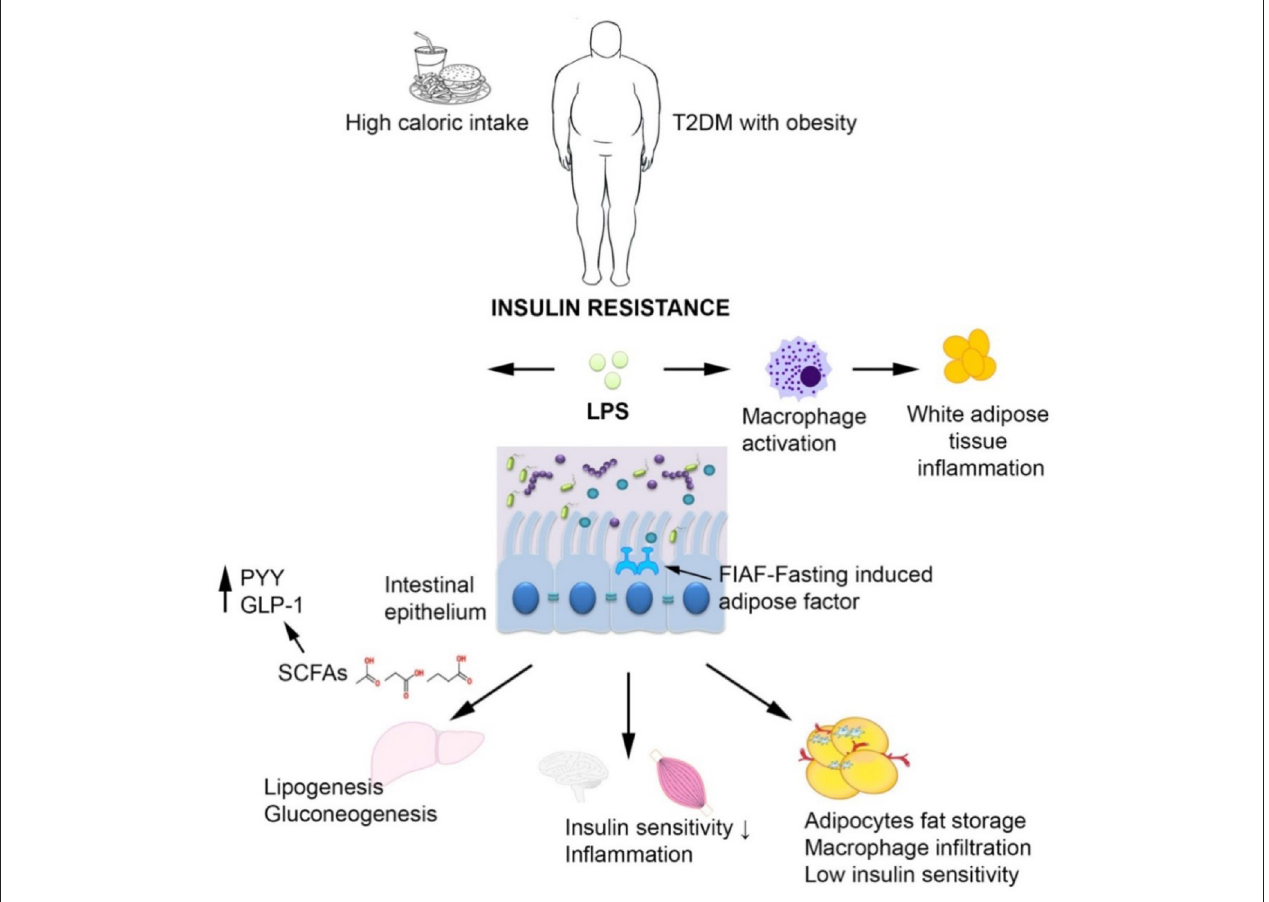
FIGURE 5 | The interplay between T2DM, obesity and the intestinal microbiota. In case of T2DM and obesity, increased intestinal permeability may trigger chronic bacterial translocation which in turn leads to systemic inflammation characterized by macrophage influx into the visceral adipose tissue, insulin resistance, and hepatic Kupffer cells activation. The short-chain fatty acids produced by the microbiota normalize gut permeability and reduce free fatty acid production.